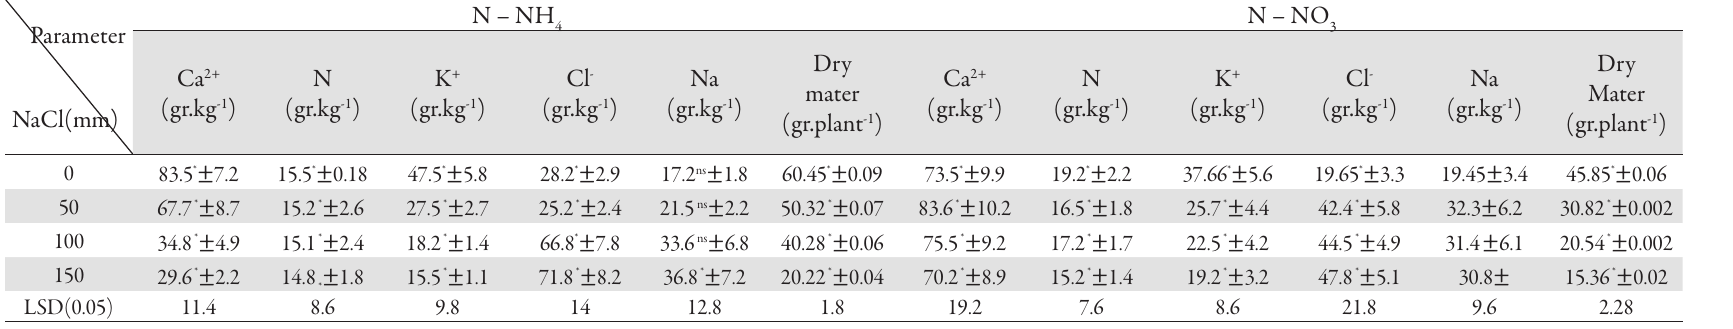
Tab .1. Effect of salinity rates in different N - forms on dry matter and nutrient concentration